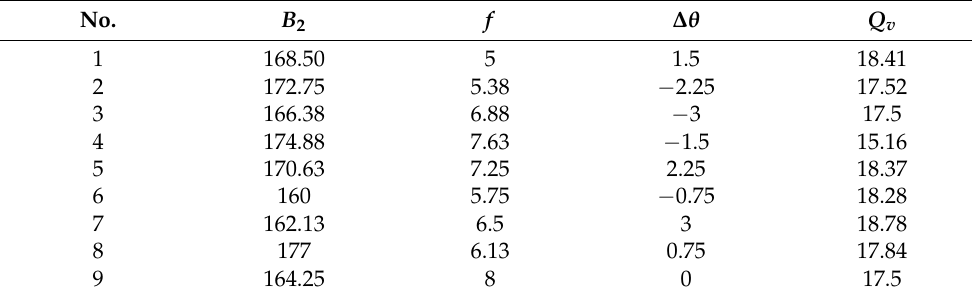
Table 4. Initial space-filling LHS.